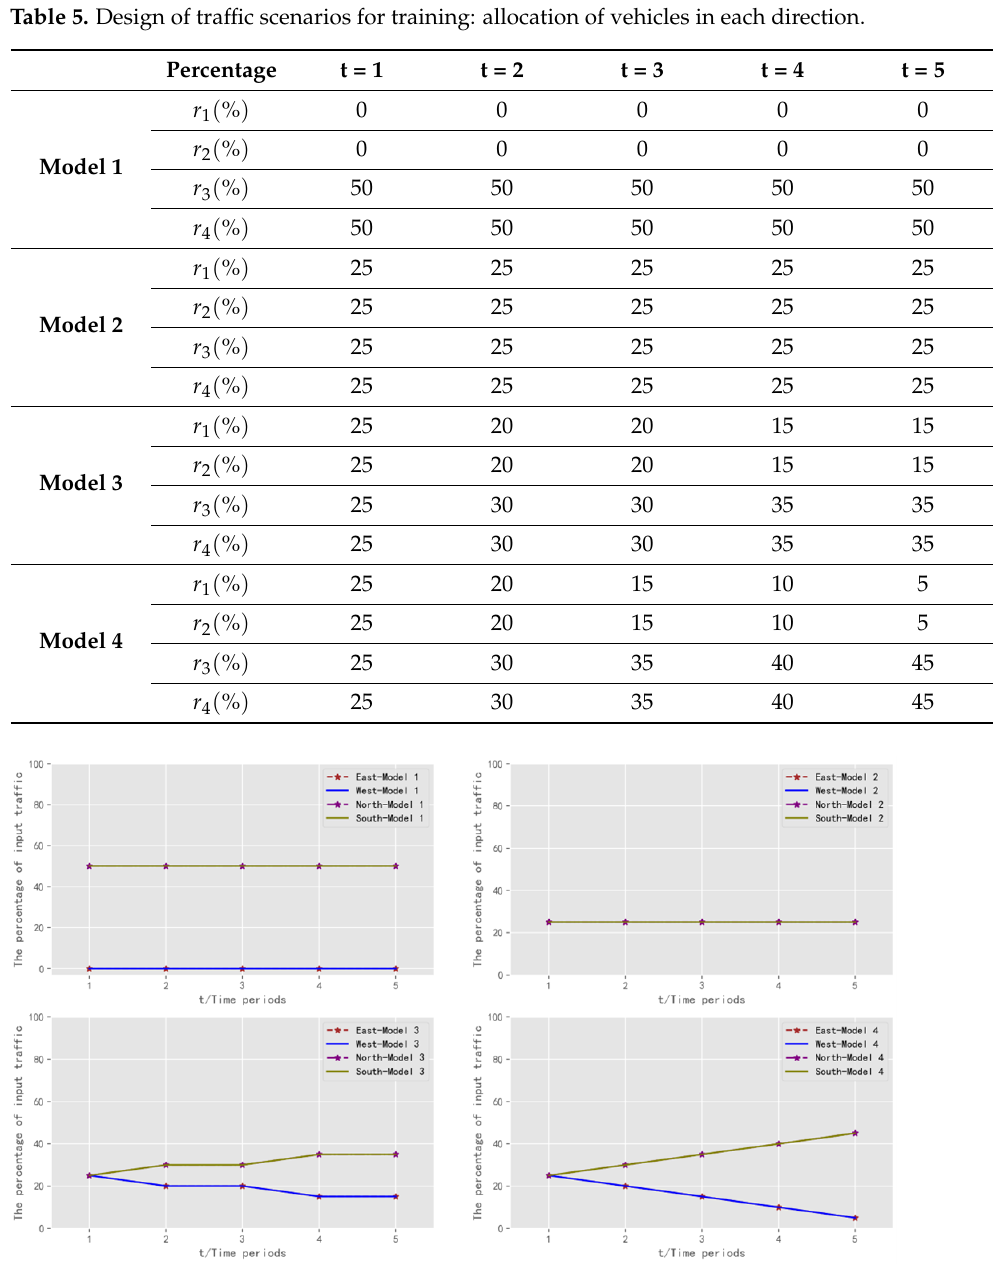
Figure 6. Diagram of traffic scenarios for training: allocation of vehicles in each direction. Table 6. Division of queue length interval.